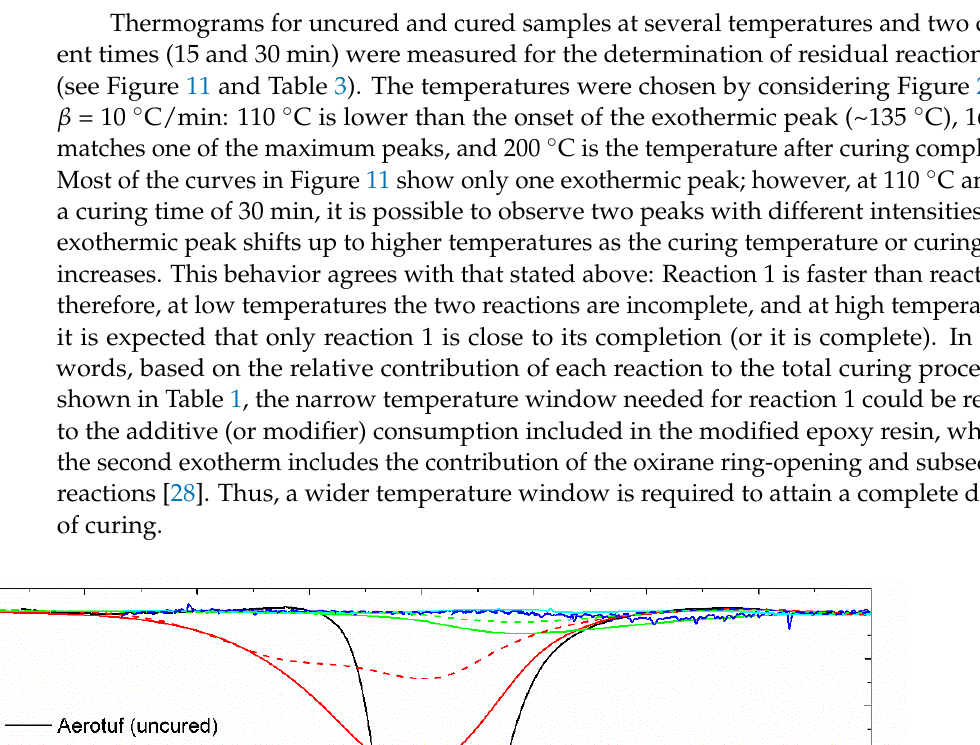
Figure 10. ( a ) Calculated isothermal thermograms by considering the autocatalytic model and the kinetic parameters of Table 2. For comparison, experimental results are shown in ( b ).